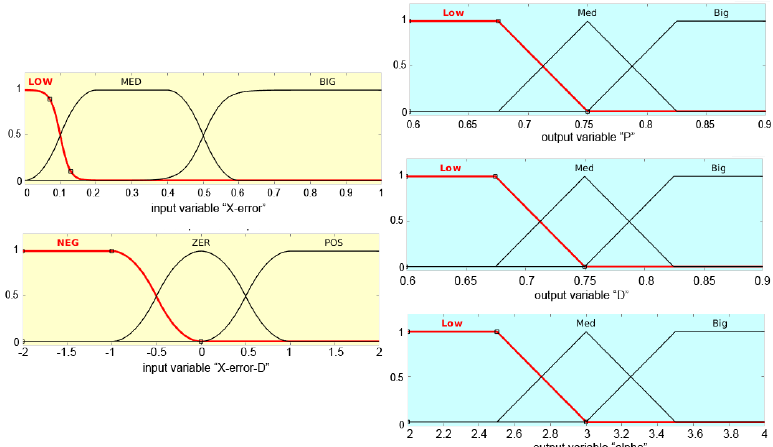
Figure 5. Fuzzy membership